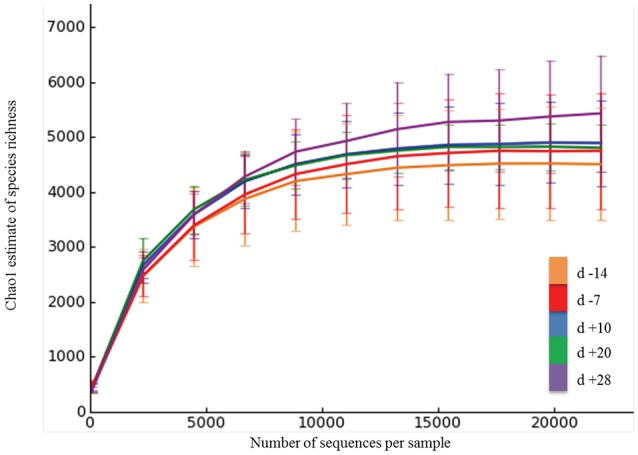
Rarefaction analysis for the observed species. The rarefaction curve was generated using Chao1 richness estimator. Samples were rarified at an even depth of 22,000 sequences per sample. Color codes denote samples collected at different days relative to calving. Error bars denote the 95% confidence intervals.